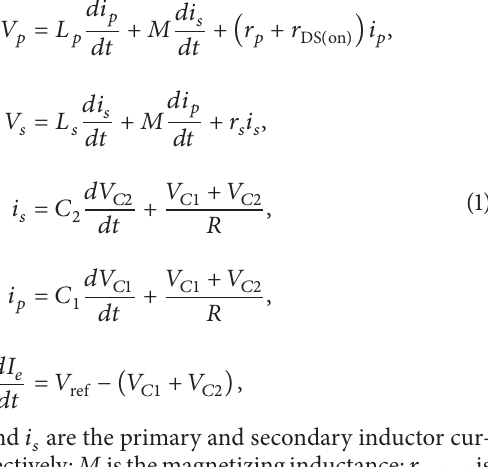
assumptions: ( 1 ) the MOSFET and diodes work as ideal switches; that is, they have only on and off positions and the change is instantaneous, ( 2 ) the diodes do not have internal resistances, ( 3 ) capacitors are ideal, and ( 4 ) the internal resistances are constant when they are